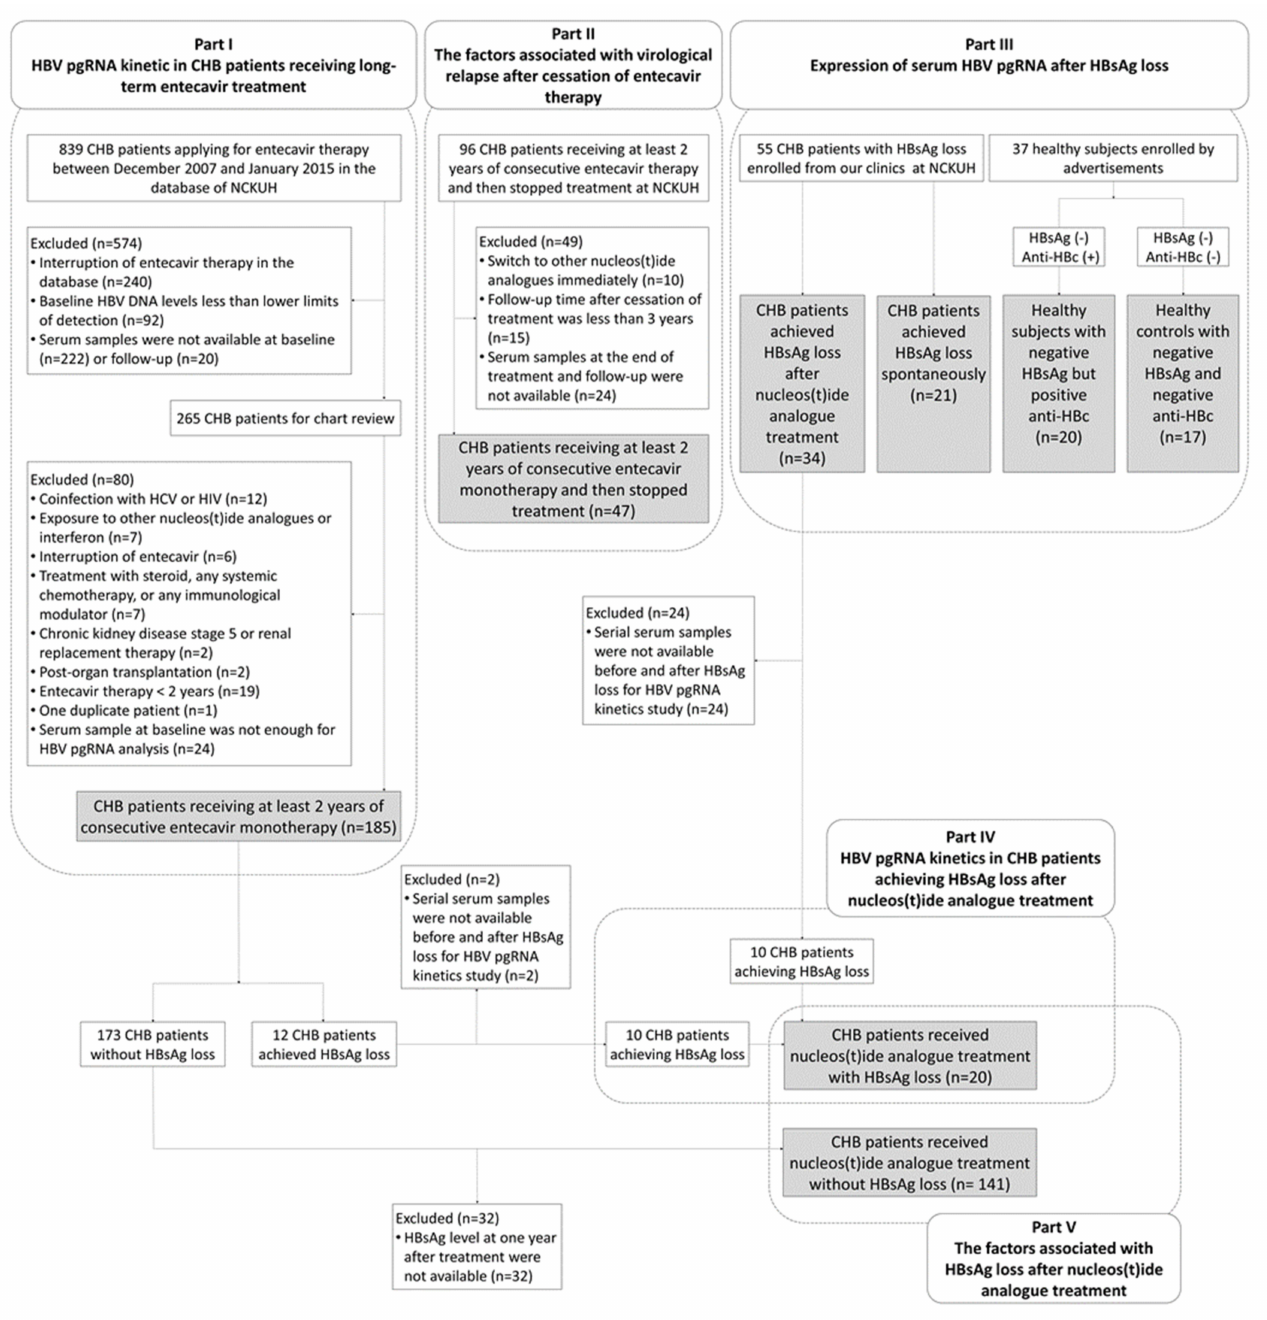
Figure 1. Patient flow diagram. Abbreviations: Anti-HBc, antibody to hepatitis B core antigen; CHB, chronic hepatitis B; HBsAg, hepatitis B surface antigen; HBV, hepatitis B virus; HCV, hepatitis C virus; HIV, human immunodeficiency viruses; NCKU, National Cheng Kung